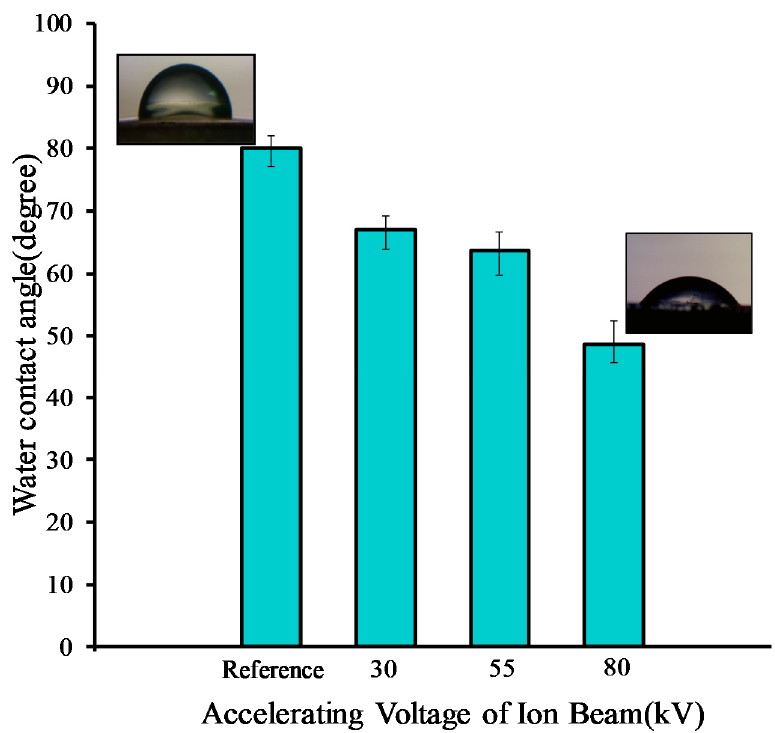
Figure 6. Comparison of the water contact angles of the chitosan membrane (reference sample) and the irradiated chitosan membrane at different accelerating voltages of ion beams .